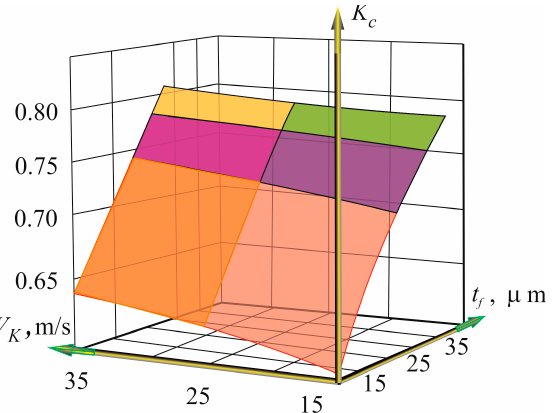
Figure 3. The effect of the speed and depth of cutting-scratching with a diamond cone on the extrusion coefficient.